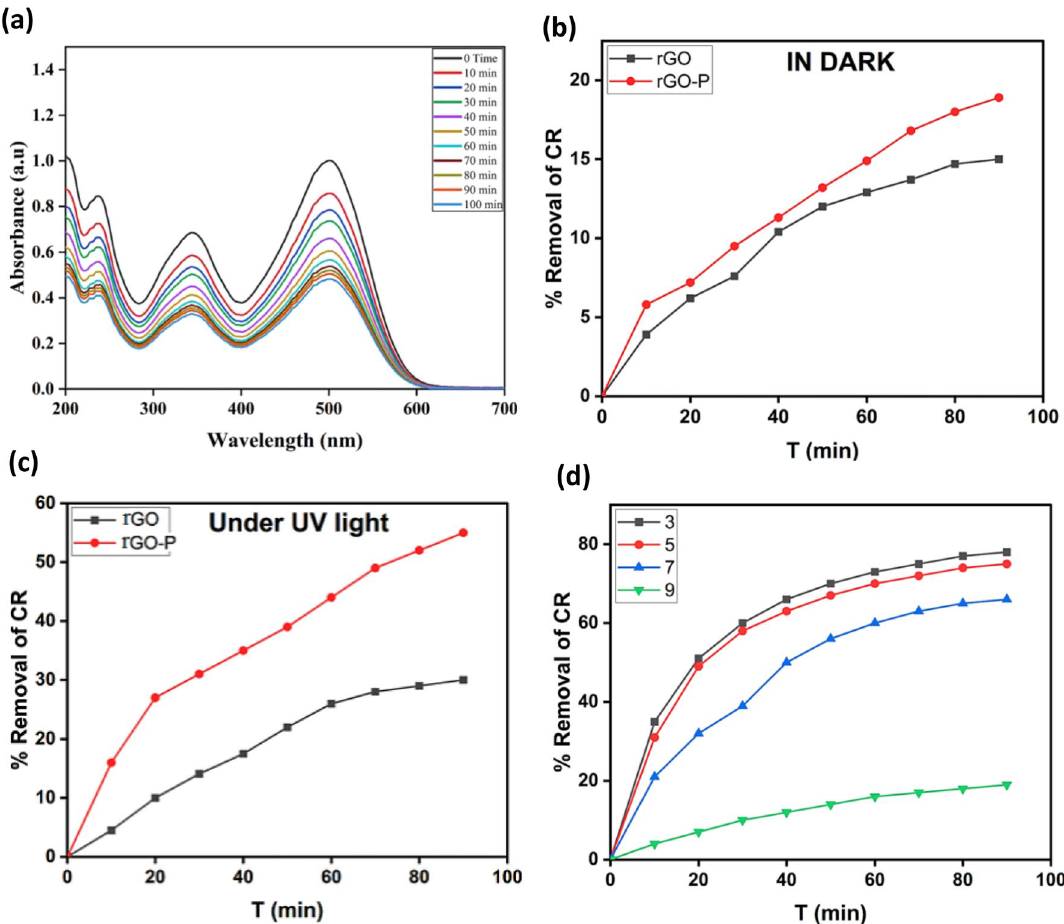
Figure 5. ( a ) UV–Visible spectra of Congo red (CR) at different concentrations with time intervals. ( b ) Removal percentage of CR within 90 min due to adsorption activity of rGO and rGO-P composite. ( c )